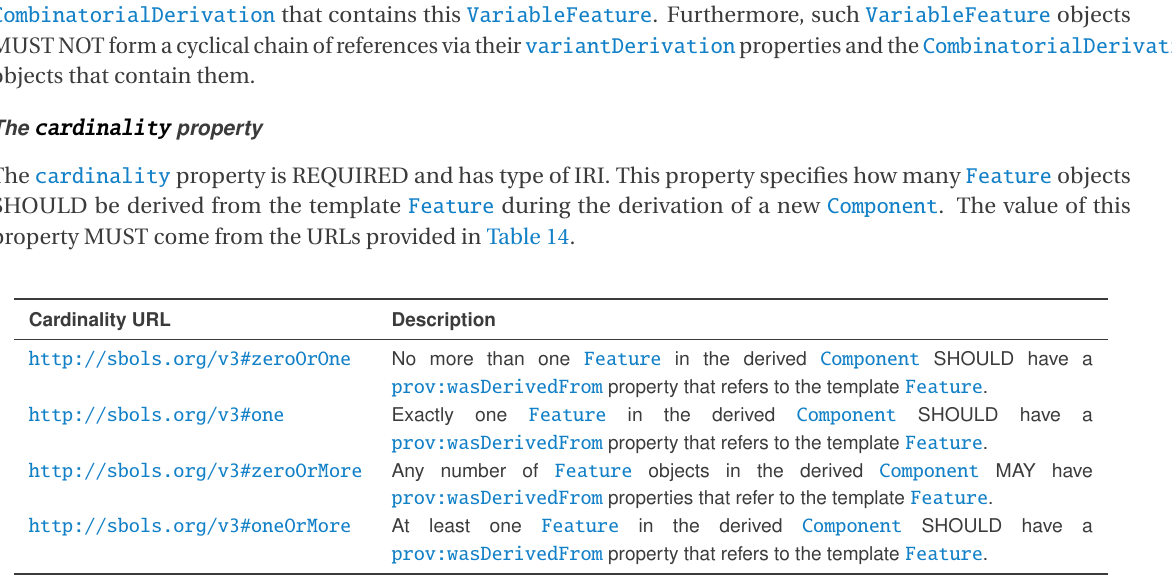
Table 14: REQUIRED URL s for the cardinality property.